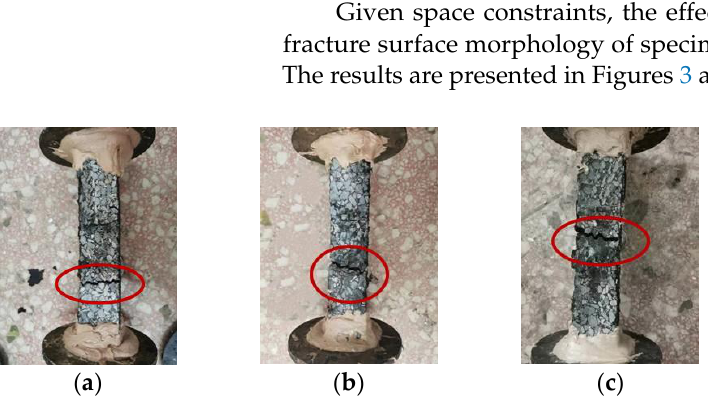
Figure 3. Crack morphology of GFSMA specimens: ( a ) 0.3 wt; ( b ) 0.4 wt%; ( c ) 0.45 wt%; ( d ) 0.50 wt%; ( e ) 0.55 wt%.